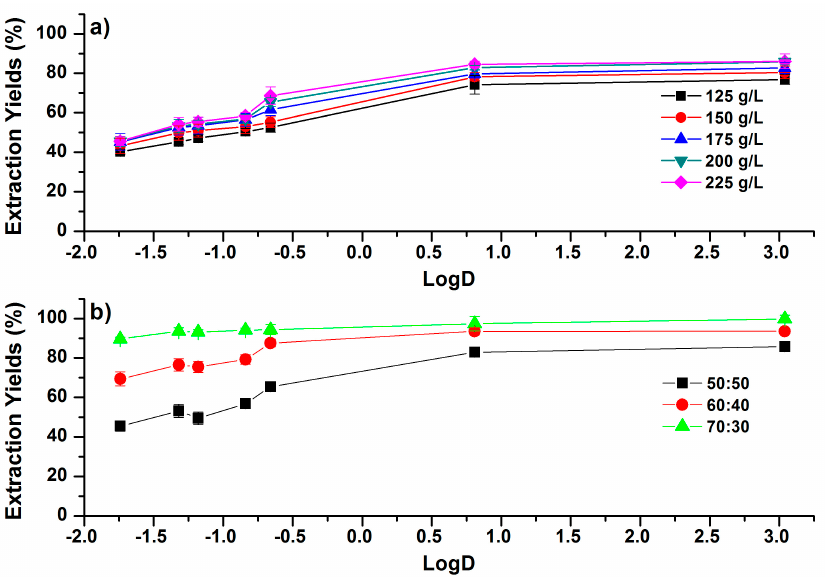
Figure 4. Correlations between EYs and the LogD (pH 7.4) values of phenolic compounds ( a ) under different addition amounts of glucose in ACN–H 2 O mixtures (50:50, v / v ); ( b ) under different concentrations of ACN in the ACN–H 2 O mixture (ACN:H 2 O, v / v ) with the addition of 200 g/L glucose. Error bars present the standard deviation ( n = 3).